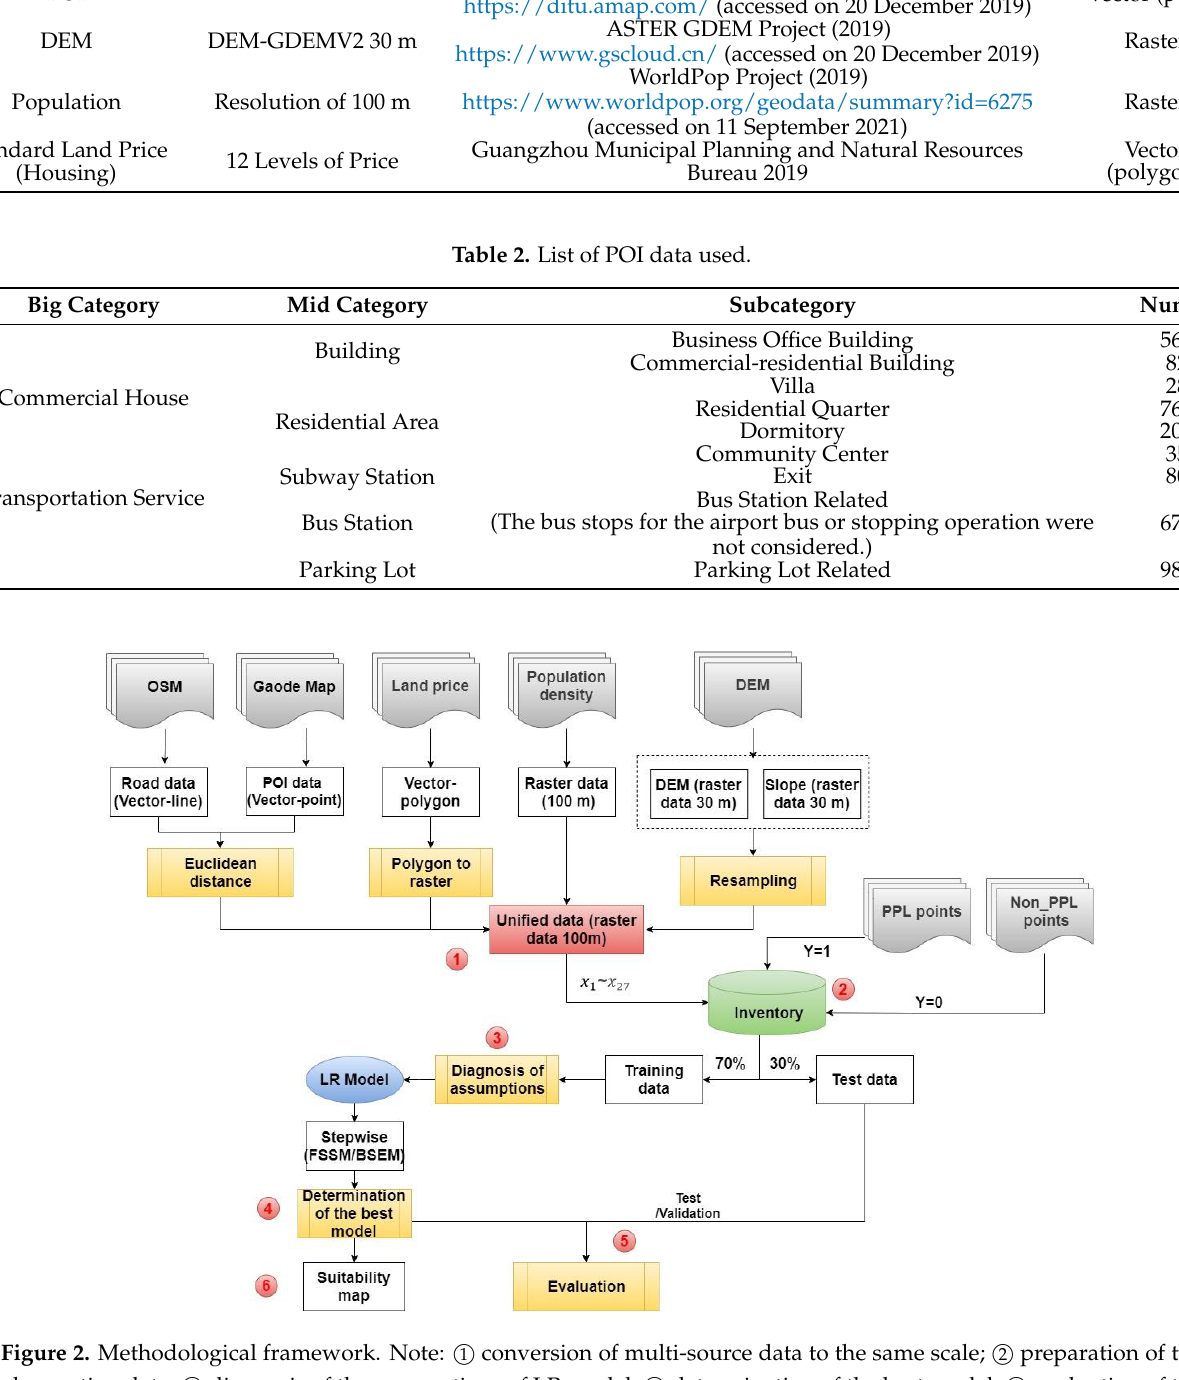
Table 3 . The abbreviations of the 27 candidate variables.